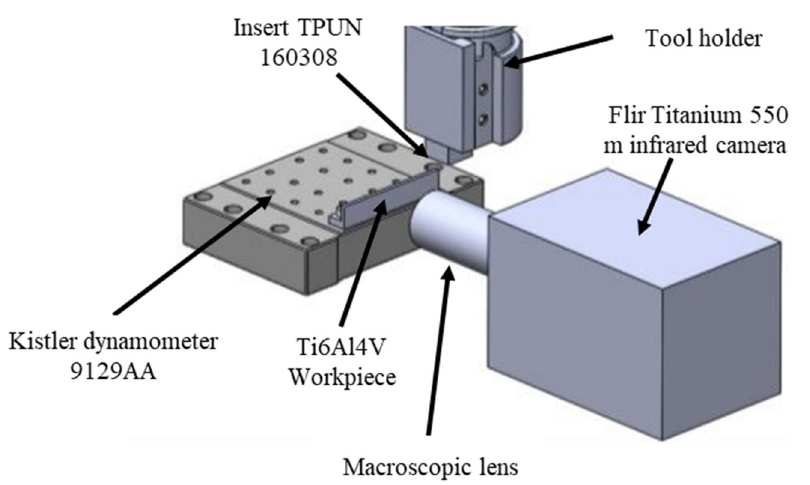
Figure 2. Experimental set up to carry out the orthogonal tests.